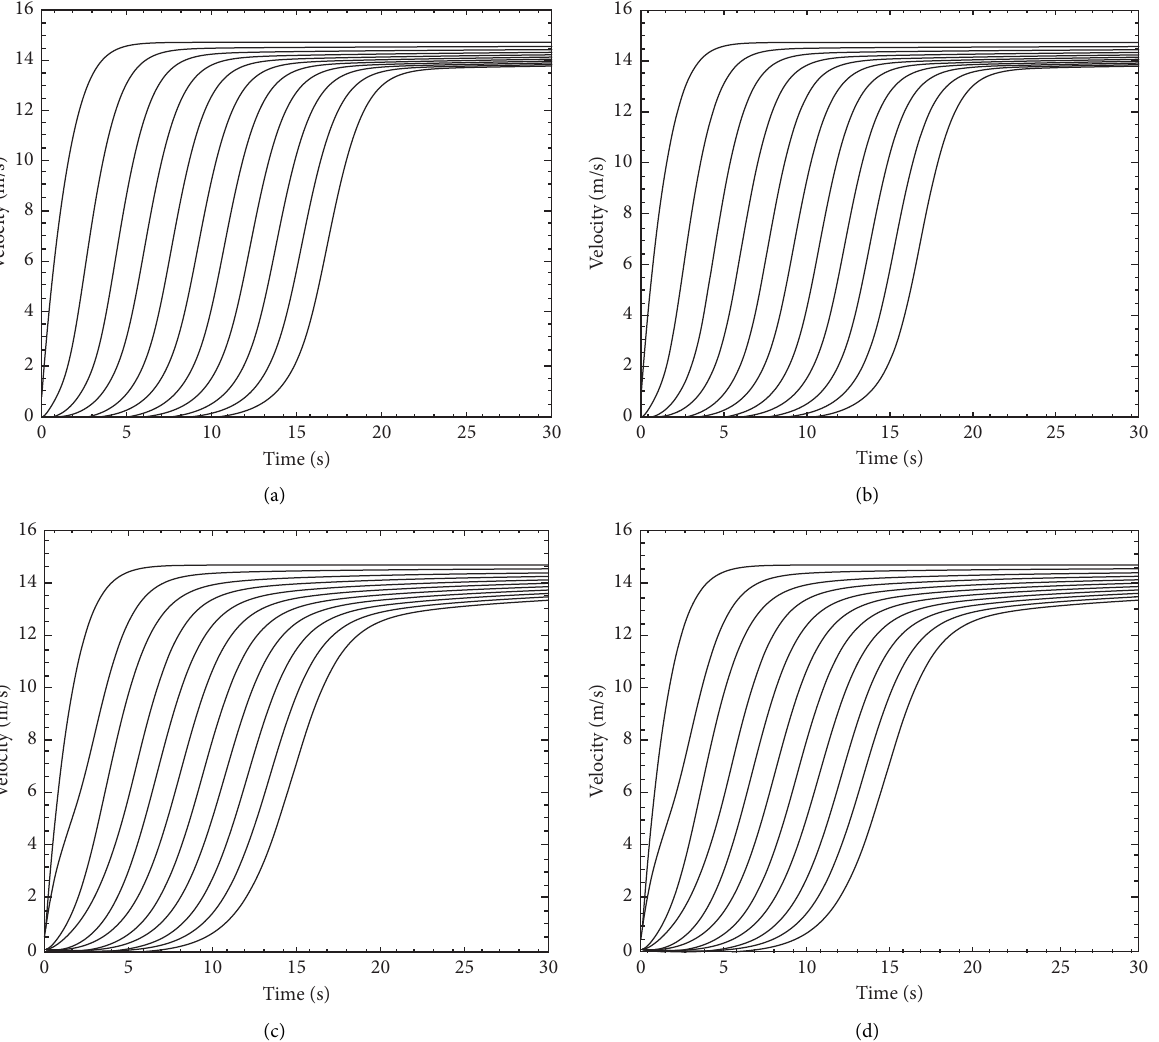
Figure 4: Motion of eleven vehicles during the departure process. (a) FVD model, (b) AFVD model ( T � 0, p � 0), (c) AFVD model ( T � 0, p � 0 . 3), and (d) AFVD model ( T � 0.1, p � 0 . 3).